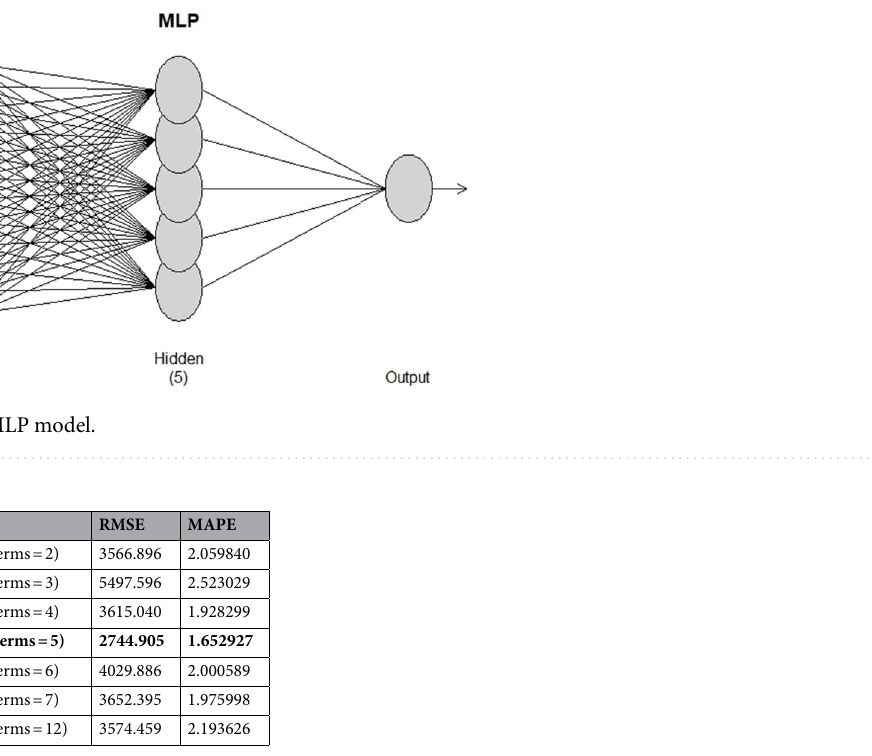
Table 3. Comparison of the performances of different MLP model trials. Significant values are in bold.